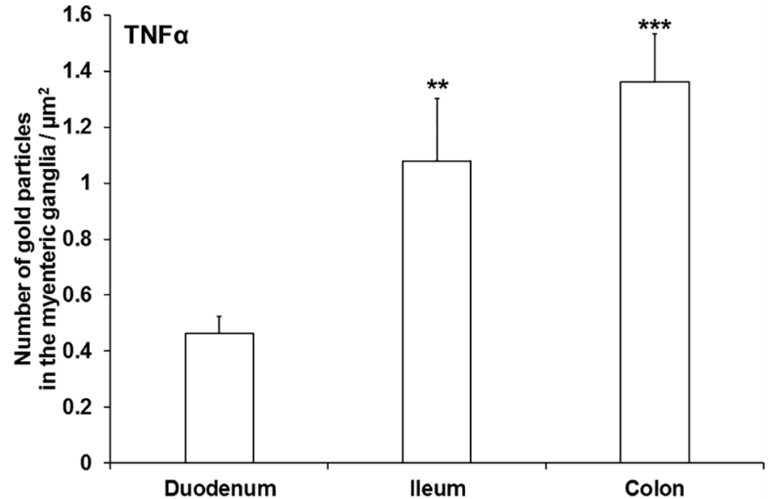
Figure 3. Quantitative evaluation of TNF α -labelling gold particles in the myenteric ganglia from different gut segments of control rats. The numbers of gold particles increased from proximal to distal direction along the gut even in healthy animals. Data were expressed as means ± SEM. ** p < 0.01; *** p < 0.001 (relative to the control duodenum).